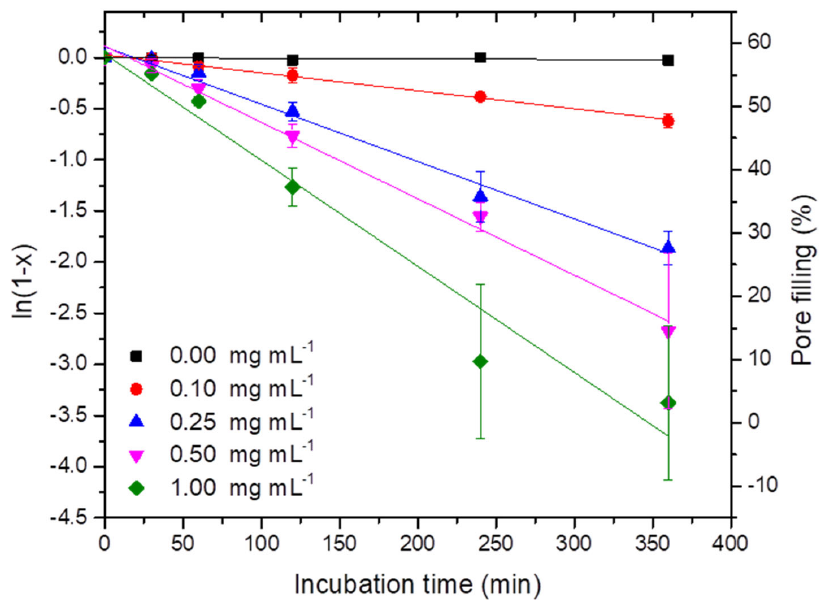
Figure 5. Plot of ln(1 − x ) ( x : extent of reaction) and the pore filling as a function of incubation time for the degradation of PLA inside pSiRF in 0.10, 0.25, 0.50 and 1.00 mg mL − 1 of proteinase K solution at 25 °C for 0, 30, 60, 120, 240 and 360 min. The pore filling was estimated based on Figure S6. The data were presented as mean ± standard deviation. The solid lines correspond to linear least-squares fit of RIfS data. All measurements were conducted in the dried state.